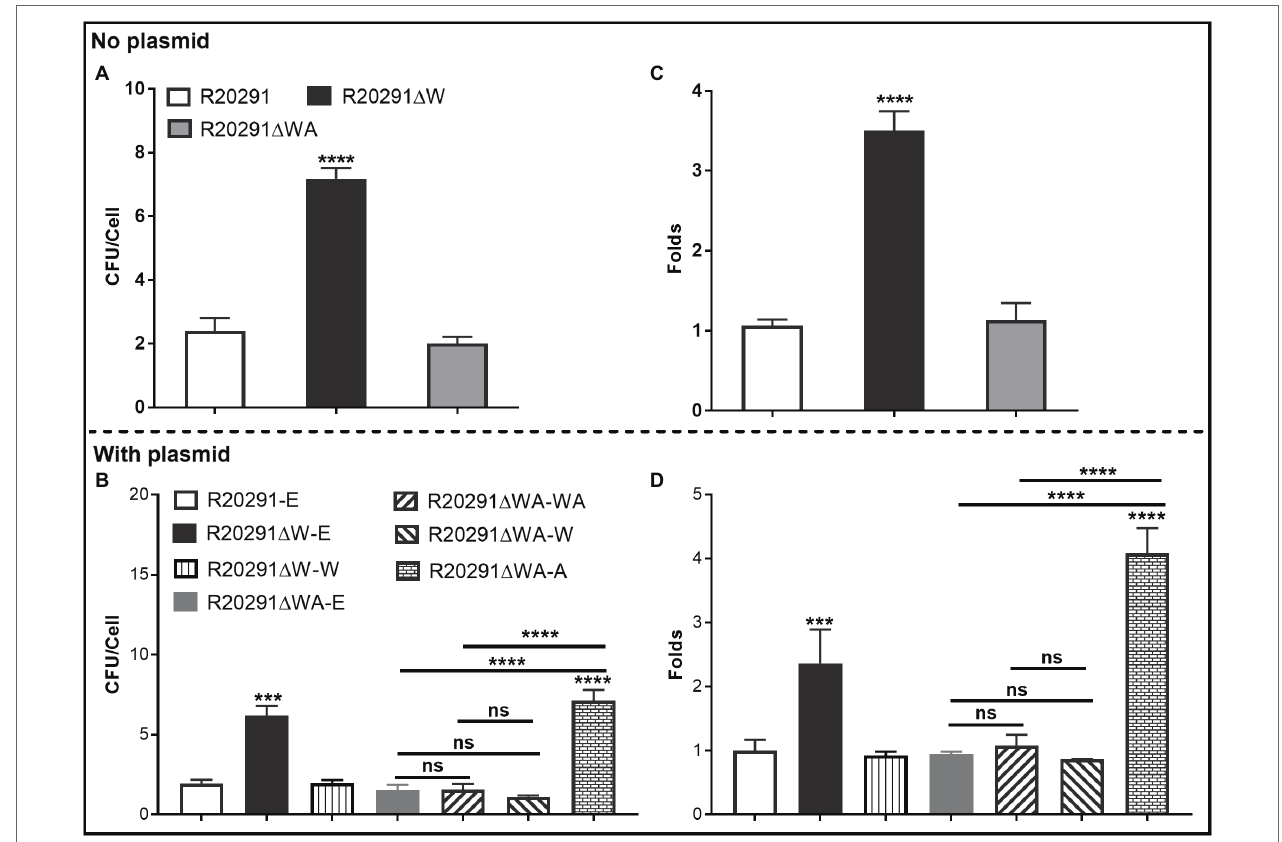
FIGURE 3 | Adhesion analysis (A,B) : Adherence of C. difficile vegetative cells to HCT-8 cells in vitro . (C,D) : Adhesion analysis with 5(6)-CFDA dye. The fluorescence intensity was scanned by the multi-mode reader (excitation, 485 nm; emission, 528 nm). The original relative fluorescence unit (RFU) was recorded as F0, after PBS wash, the RFU was recorded as F1. The adhesion ratio was calculated as follows: F1/F0. Experiments were independently repeated thrice. Bars stand for mean ± SEM (* p < 0.05, ** p < 0.01, *** p < 0.001, and **** p < 0.0001). One-way ANOVA with post hoc Tukey test was used for statistical significance. * directly upon the column means the significant difference of the experimental strain compared to R20291 or